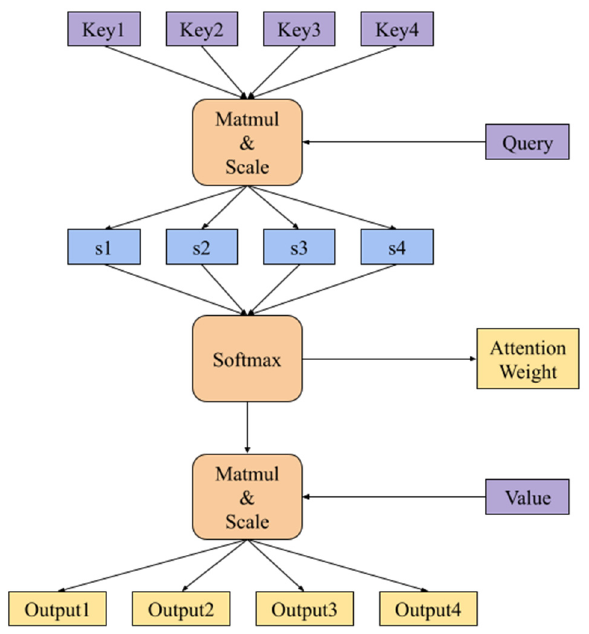
Figure 2. Scale dot product attention.